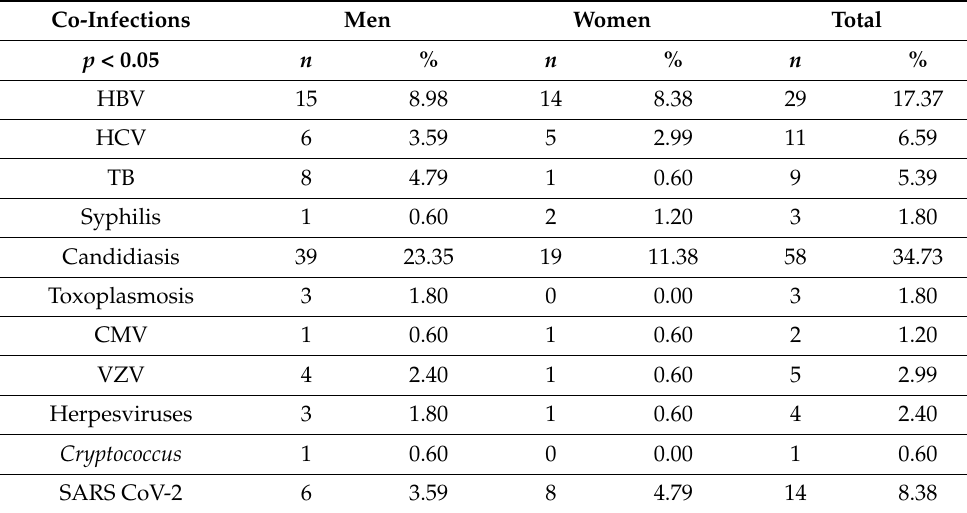
Table 8. Distribution of new HIV/AIDS cases by